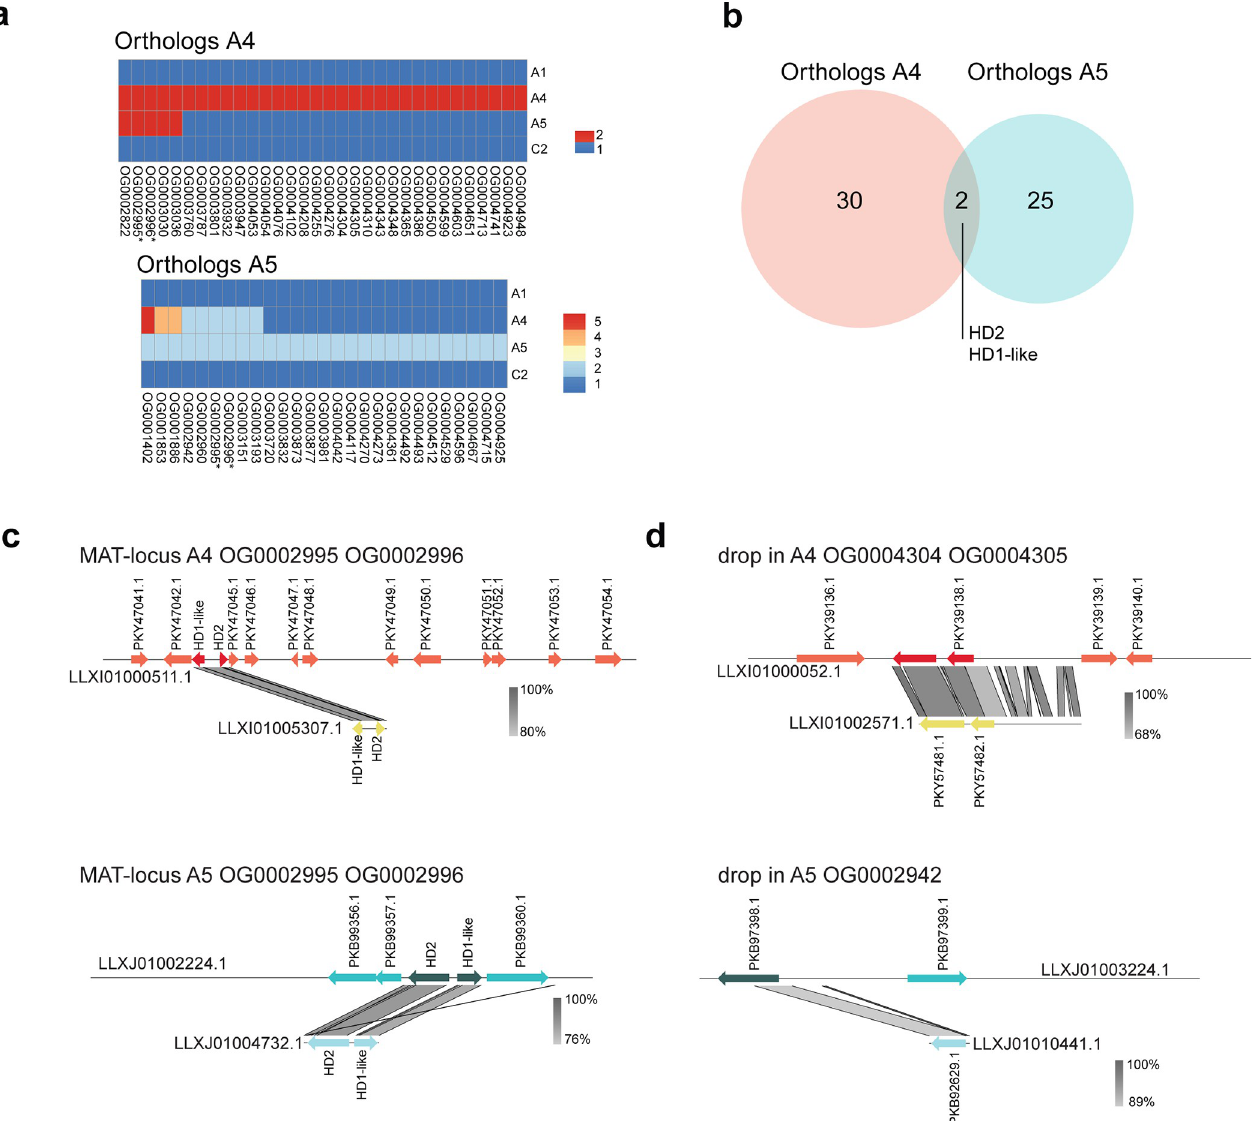
Fig 2. Identification of orthologs of genes present in regions showing a drop in coverage. a, Orthologous groups that display two or more genes in dikaryons and only a single gene in monokaryons. This analysis was performed independently on isolate A4 and isolate A5. � orthologous groups where HD2 and HD1-like genes are present. b, Venn diagram representing the number of shared orthologous groups within drop in coverage regions between isolates A4 and A5. Only two orthologous groups were shared between the isolates, they contain the putative MAT-locus genes HD2 and HD1-like. c, Synteny plot between the two contigs containing the different alleles of the putative MAT-locus of isolates A4 and A5. d, Synteny plot between the two contigs containing different alleles of other orthologous genes. Please note that the synteny figures are made from the public available annotations of each genome assembly. Differences in size of open-reading frames (ORF) among isolates are due to differences in detection of ORF on each isolate and likely could be the result of the annotation process.